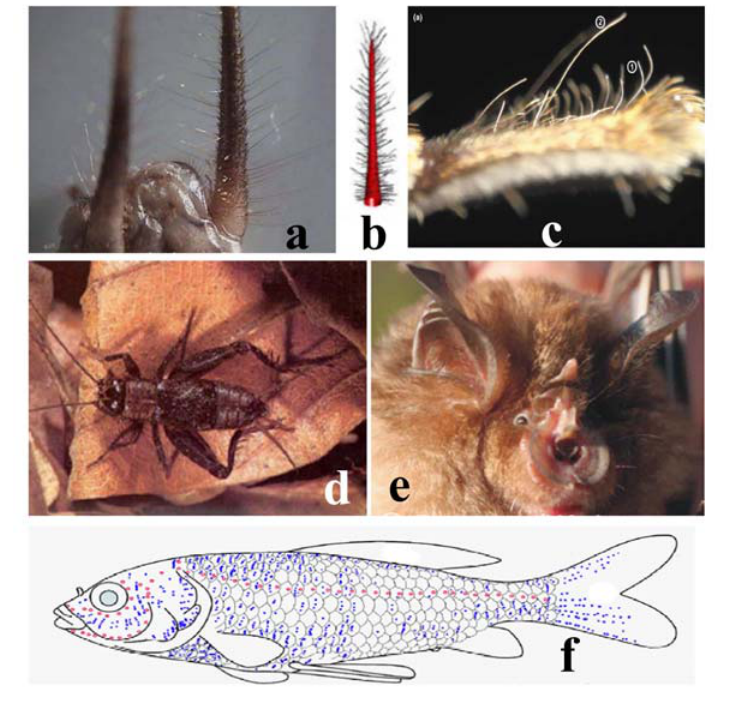
Figure 2. Hair cell receptor existing in many animals; (a, b, d) cricket cerci [17], (c) a spider tarsus [18], (e) bat hearing system [19], (f) goldfish ( Carassius auratus ) lateral line system